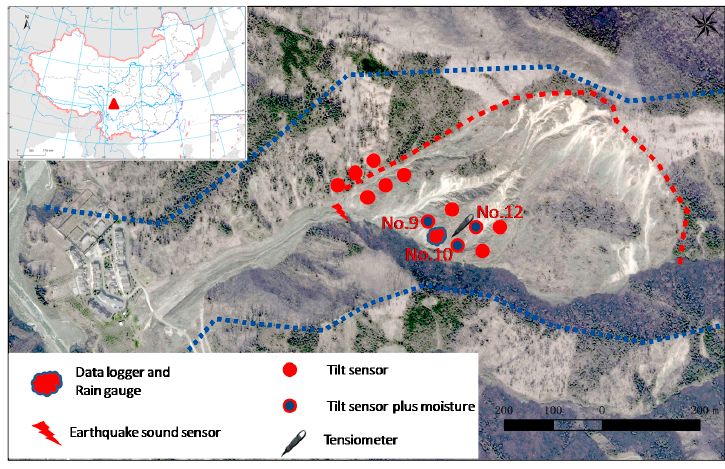
Figure 3. Location of the in situ monitoring site, which is conducted on a natural landslide site